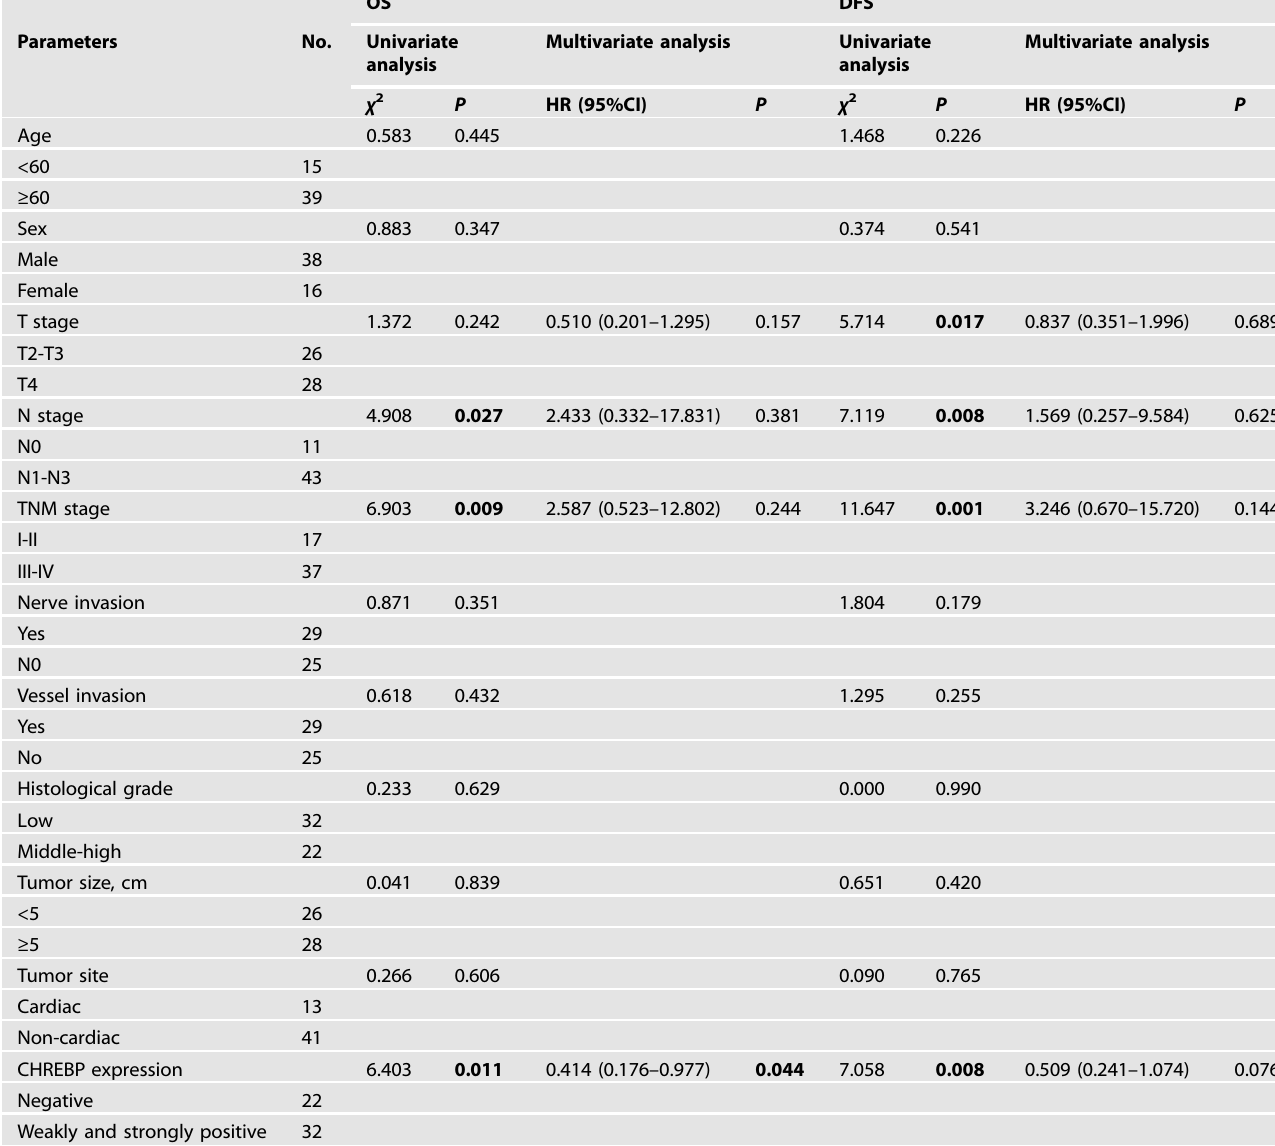
Table 2. The results of univariate and multivariate logistic regression